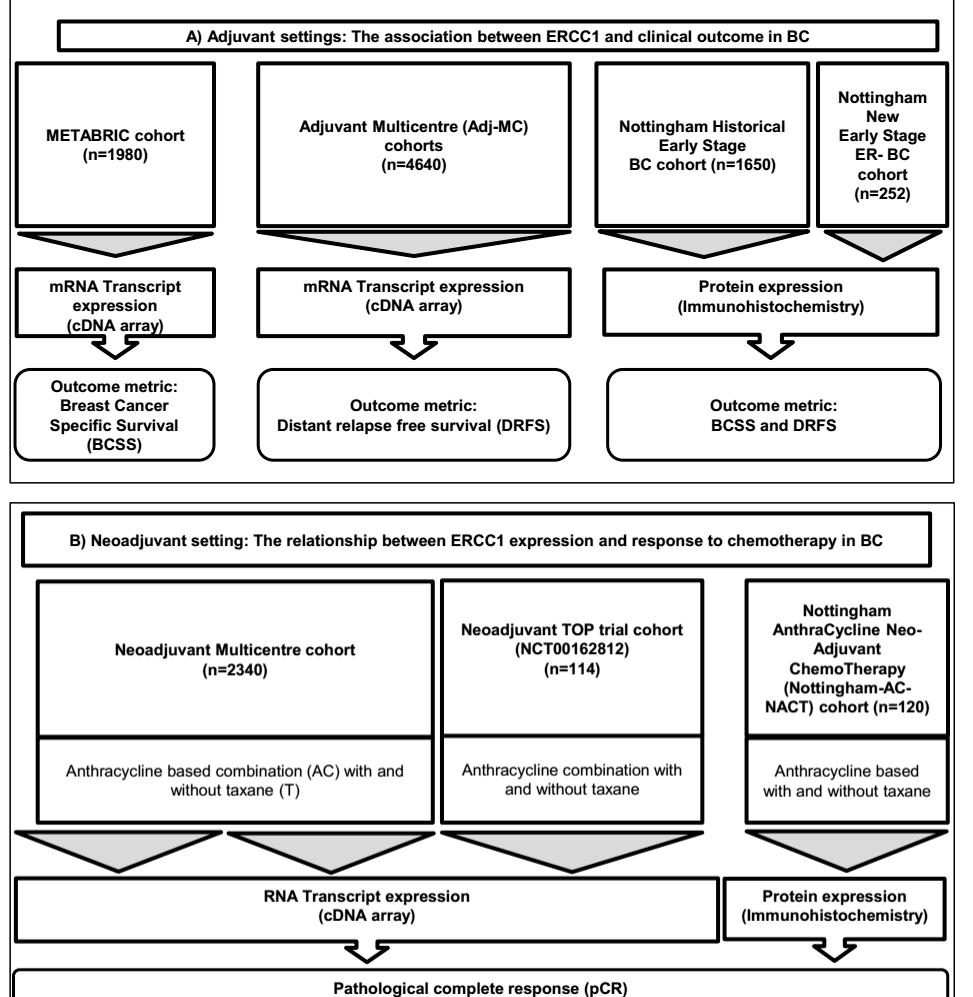
Figure 3. Consort diagram summarizing patient cohorts investigated in the current study.